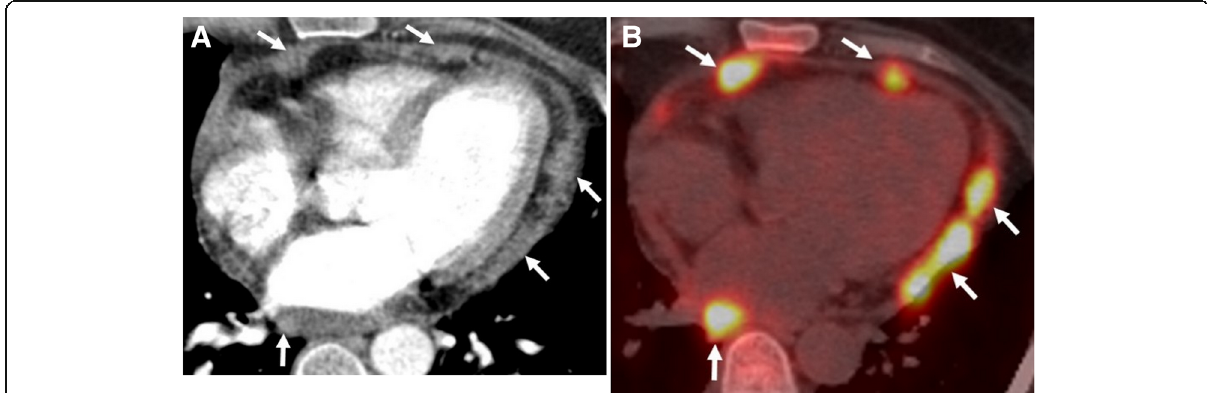
Fig. 19 A 55-year-old woman with pathologically proven squamous cell carcinoma metastases from unknown origin. a Axial contrast-enhanced CT image demonstrates the nodular areas of pericardial thickening (arrows). b PET-CT scan reveals increased FDG uptake (arrows) at the same areas